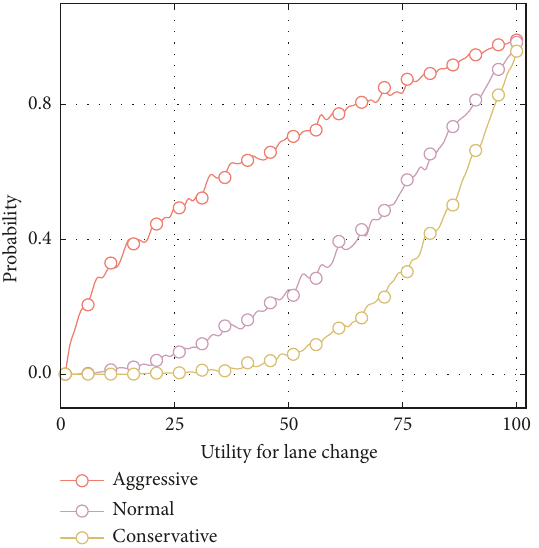
Figure 4: The utility for lane-changing behaviors.